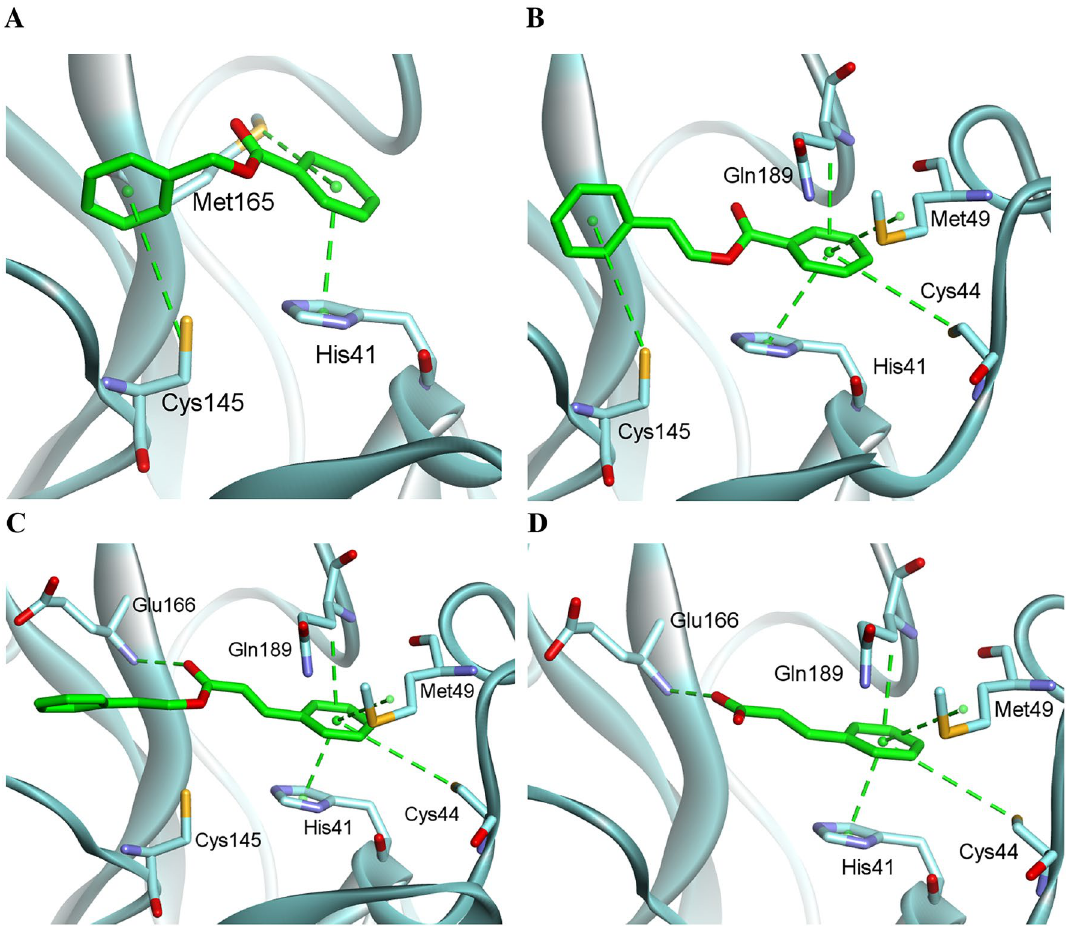
Figure 2. The interactions of benzyl benzoate ( A ), benzyl cinnamate ( B ), cinnamyl cinnamate ( C ), and cinnamic acid ( D ) in the active center of SARS-CoV-2 M pro . The ligands and the side chains of the amino acids are shown as sticks, and the bond order is not